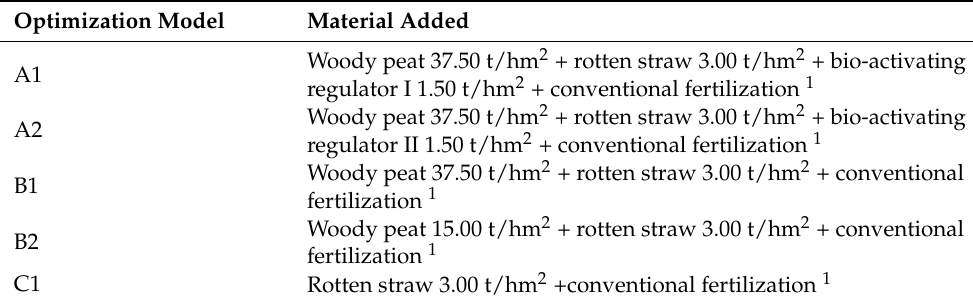
Table 2. Type and amount of excipients added in the different optimization